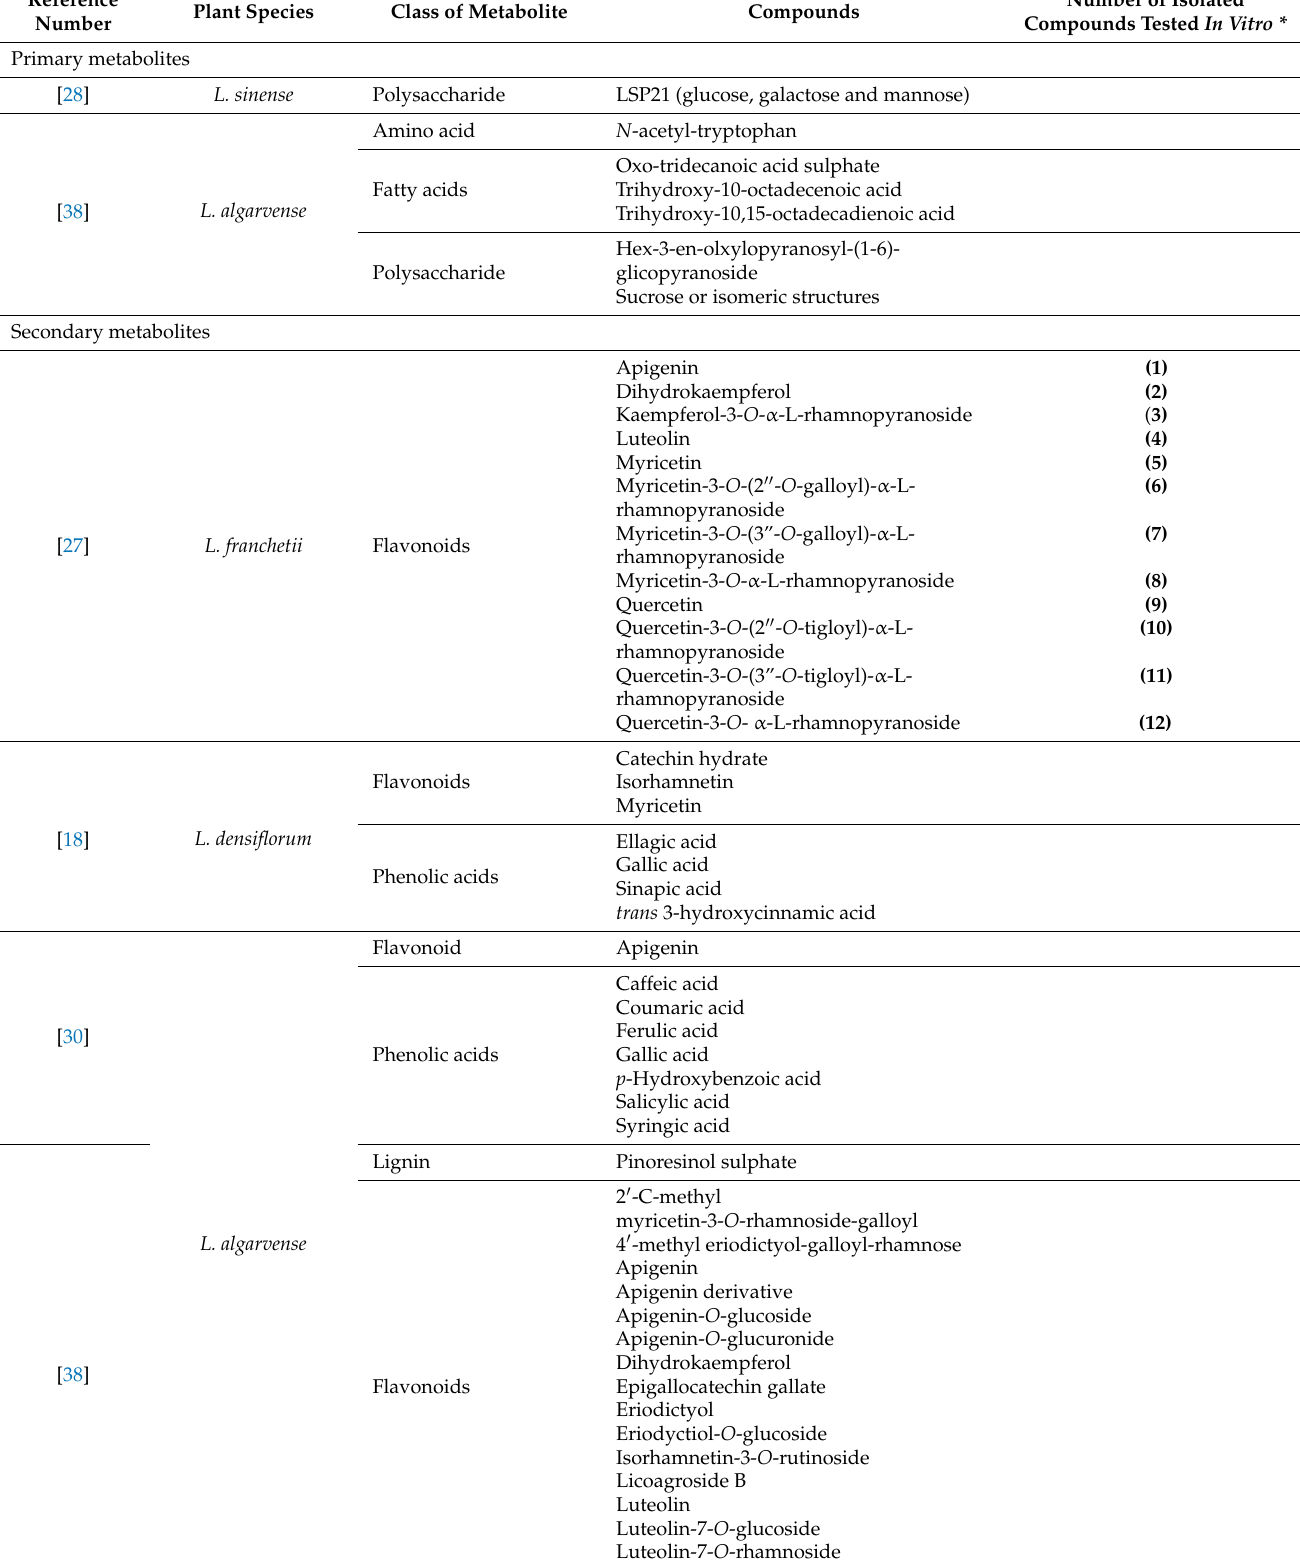
Table 2. Phytochemistry of Limonium species included in the systematic